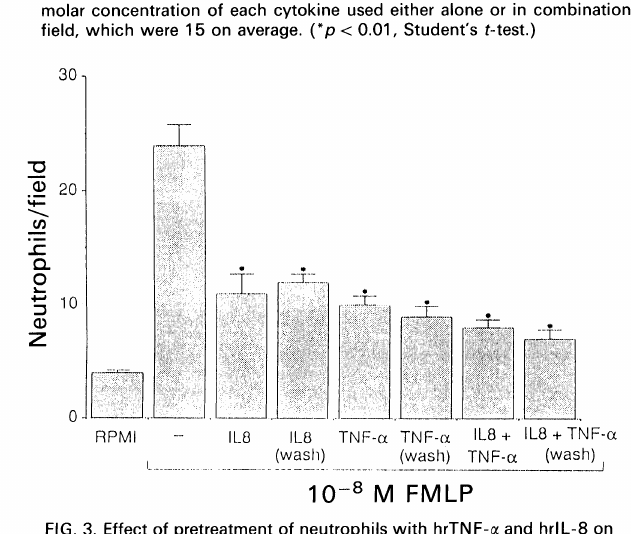
FIG. 2. Dose response effect of hrTNF- and hrlL-8, individually or combined, on neutrophil chemotaxis induced by FMLP. Subtitles indicate molar concentration of each cytokine used either alone or in combination. Results are reported as means _+ S.E.M. of the number of neutrophils per field, which were 15 on average. (*p < 0.01, Student’s t-test.)